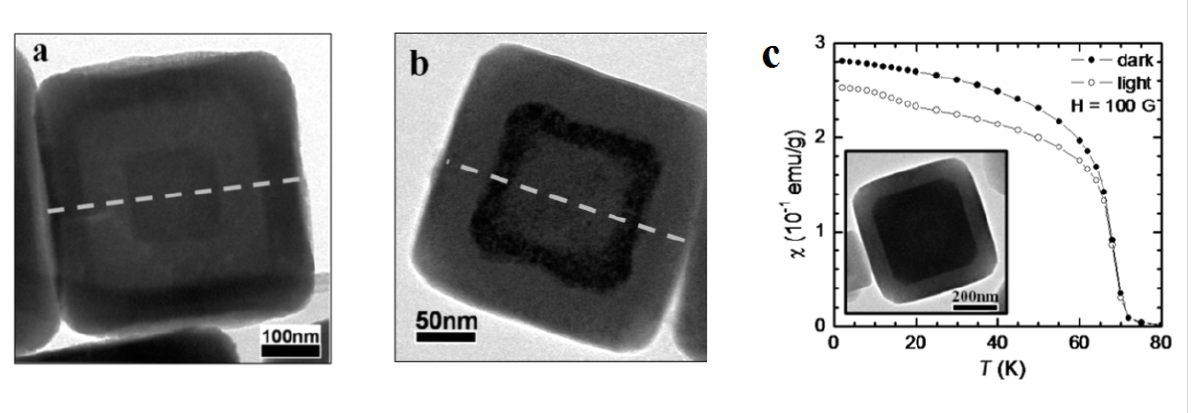
Figure 5: HRTEM images of core–multishell PBA nanoparticles a) RbCoFe@KNiCr@RbCoFe and b) KNiCr@RbCoFe@KNiCr, and c) shows the field-cooled magnetic susceptibility as a function of temperature before and after light irradiation of RbCoFe@KNiCr. Adapted with permission